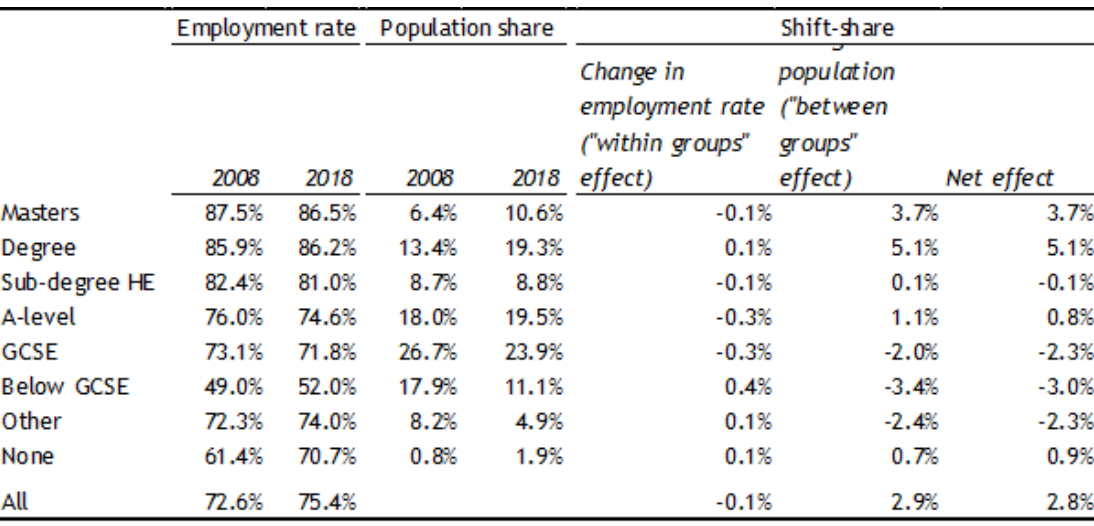
Table 6: Employment and population changes by qualification, 16-64 year olds: